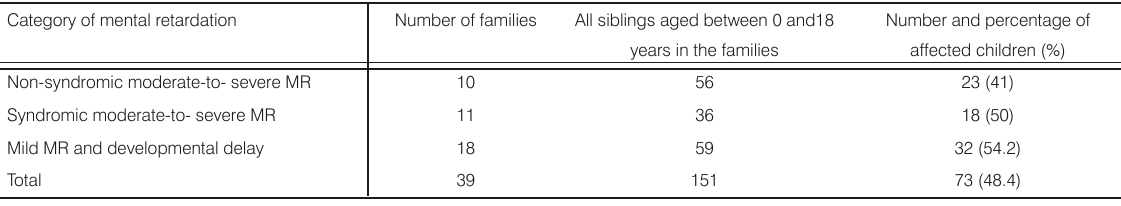
FC, first cousins; DR, distant relatives Table 2. Distribution of Mental Retardation Spectrum Disorders in Village